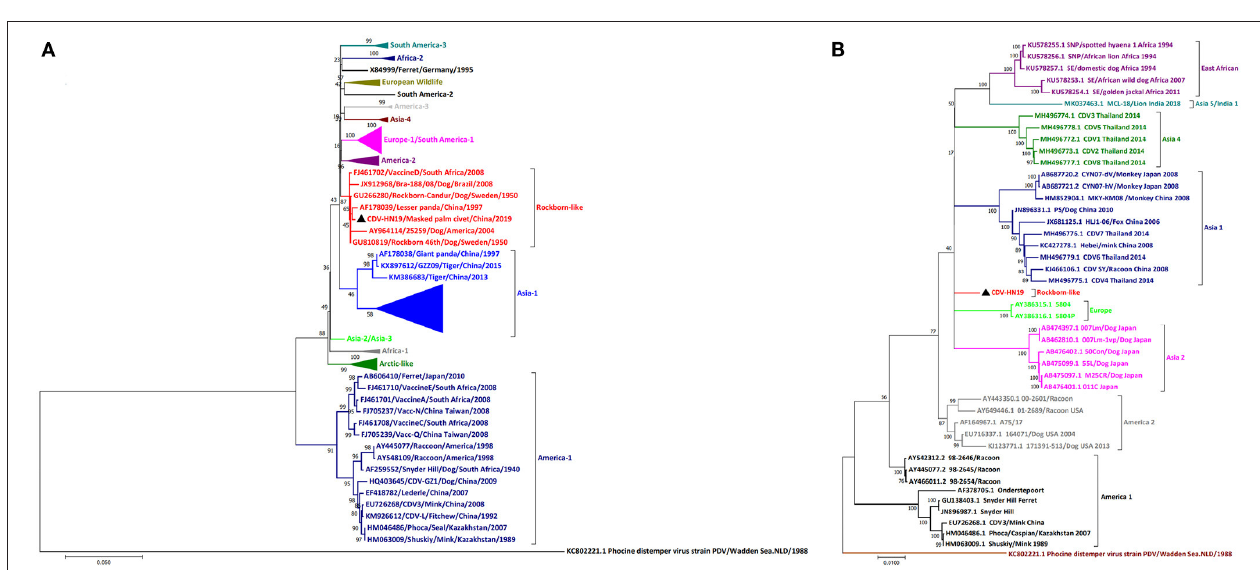
FIGURE 2 | Phylogenetic analyses of CDV HN19 strain. (A) Phylogenetic analyses of the nucleotide sequences of the complete genome of CDV HN19 strain. (B) Phylogenetic analyses of H gene nucleotide sequences of CDV HN19. Evolutionary history was inferred using the maximum likelihood method with the Tamura-Nei model and gamma-distributed rate heterogeneity in MEGA 7. The percentage of replicates in which the associated virus clustered together in the bootstrap test (1,000 replicates) is shown next to the branch in each tree. The strain isolated in this study is identified by N . The percentage bootstrap support is indicated by the value at each node. Scale bar denotes nucleotide substitutions per